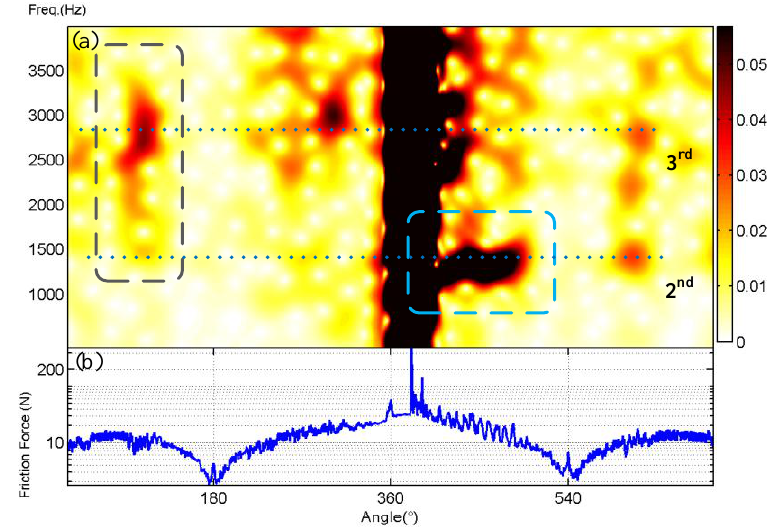
Figure 15. The STFT of friction force predicted by the improvel model: ( a ) STFT of the predicted friction force; ( b ) The predicted friction force.